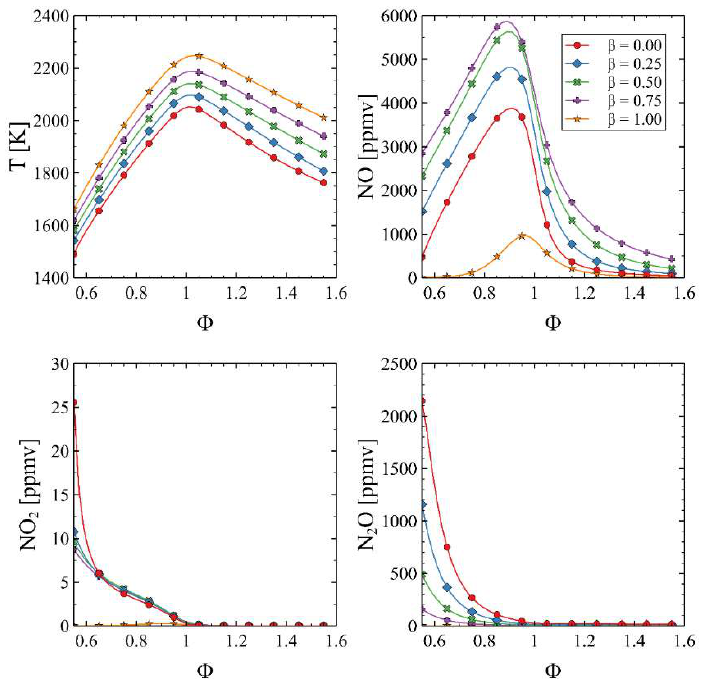
Figure 2. Effect of equivalence ratio on temperature and NO, NO 2 , and N 2 O mole fractions in a PSR ( τ PSR = 0.1 s).